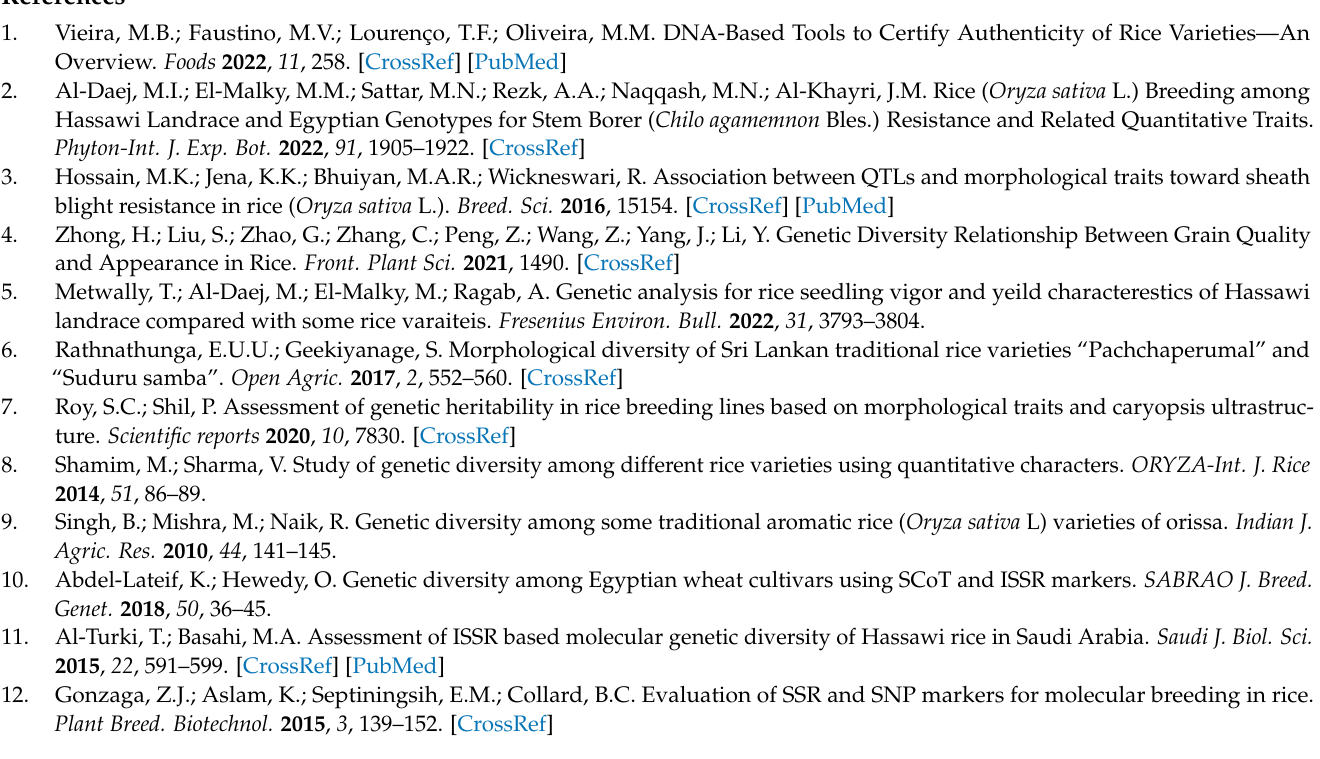
Figure S2: STRUCTURE analysis of 12 rice genotypes using ISSR and SSR data. (a) Number of groups best supported by ∆ K approach (i.e., K = 2). STRUCTURE output for K = 2, with two different colors representing two different groups. Each bar represents an individual genotype, and the different colors represent the estimated membership coefficients of every genotype in each identified group (Q matrix); Figure S3: Distribution of pairwise relative kinship across 12 rice genotypes using ISSR and SSR data. Each bar represents the percentage of genotypes in different kinship range